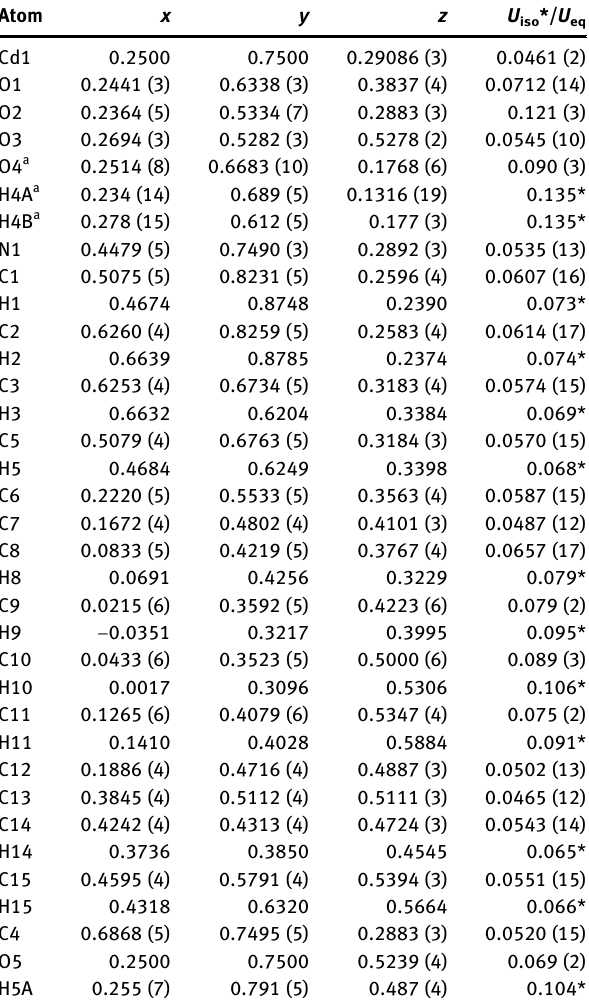
1,4-bis(2 ′ -carboxylatophenoxy)benzene (H metal ions. Herein, we report a cadmium(II) compound with two-dimensional structure,